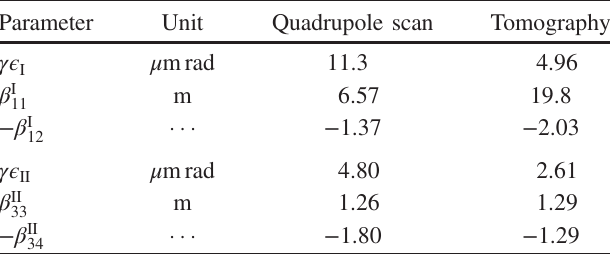
TABLE VII. Comparison of values for emittances and Courant- Snyder parameters determined from a quadrupole scan and tomography in four-dimensional phase space. The normal mode parameters are used to take coupling into account [103]: In the limit of zero coupling, the emittances ϵ and ϵ correspond I II (respectively) to ϵ and ϵ , and the optical functions β I 11 , − β I 12 , x y β II − β II β , α , β , and α 33 , and 34 correspond (respectively) to x x y y